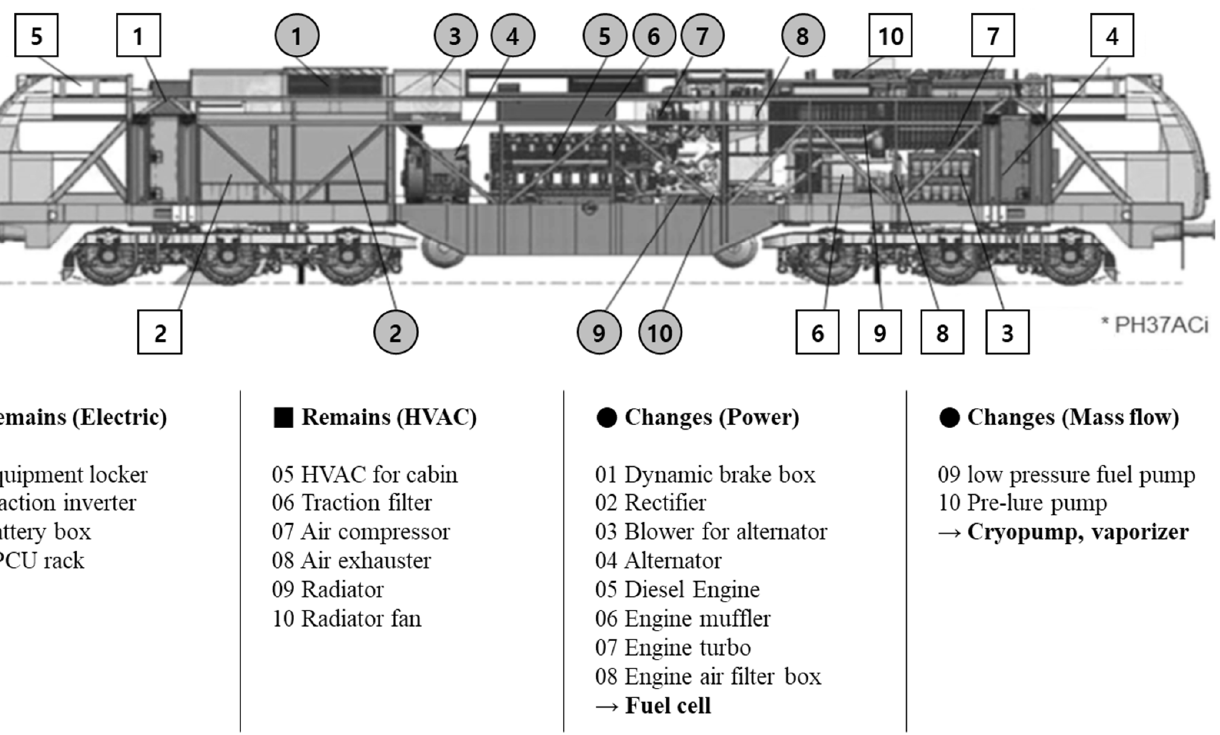
Figure 8. Fuel tank design: ( a ) size of a conventional diesel fuel tank at the bottom of the vehicle, ( b ) arrangement of 1-m-diameter tanks, and ( c ) arrangement of 0.72-m-diameter tanks. Secondly, the design of the LH 2 tank can be considered. A vessel with a low surface- to-volume ratio shows a good insulation effect. However, the cylinder type is preferred to the sphere type because of the efficiency in space utilization. The cylindrical tank with a diameter of 0.72 m and a length of 2.7 m has a capacity of 500 L or 35 kg. If the tank space